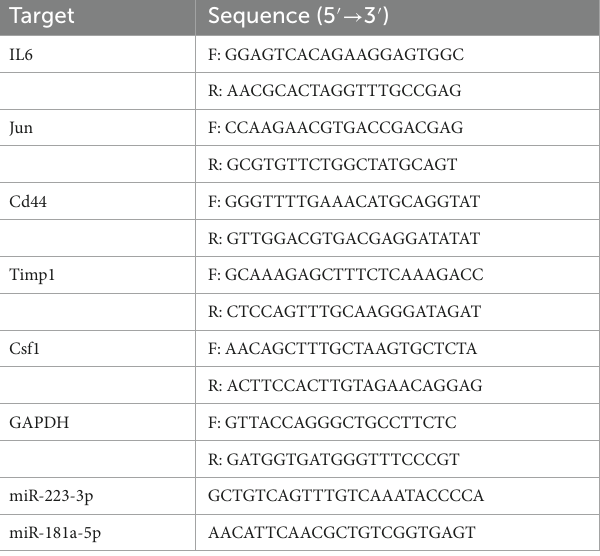
TABLE 1 Quantitative real-time polymerase chain reaction (RT-PCR) primer